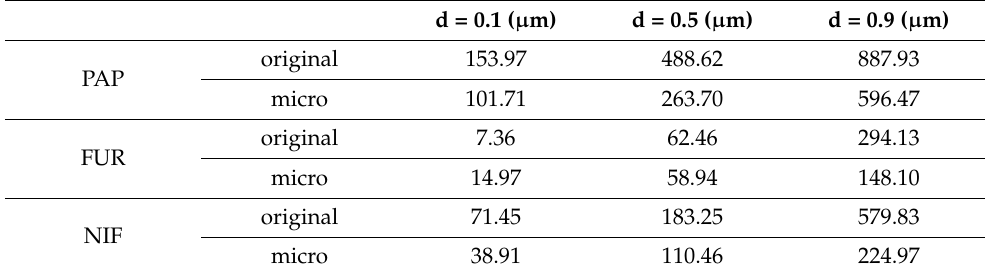
Table 2. Particle size distribution of the original and the micronized